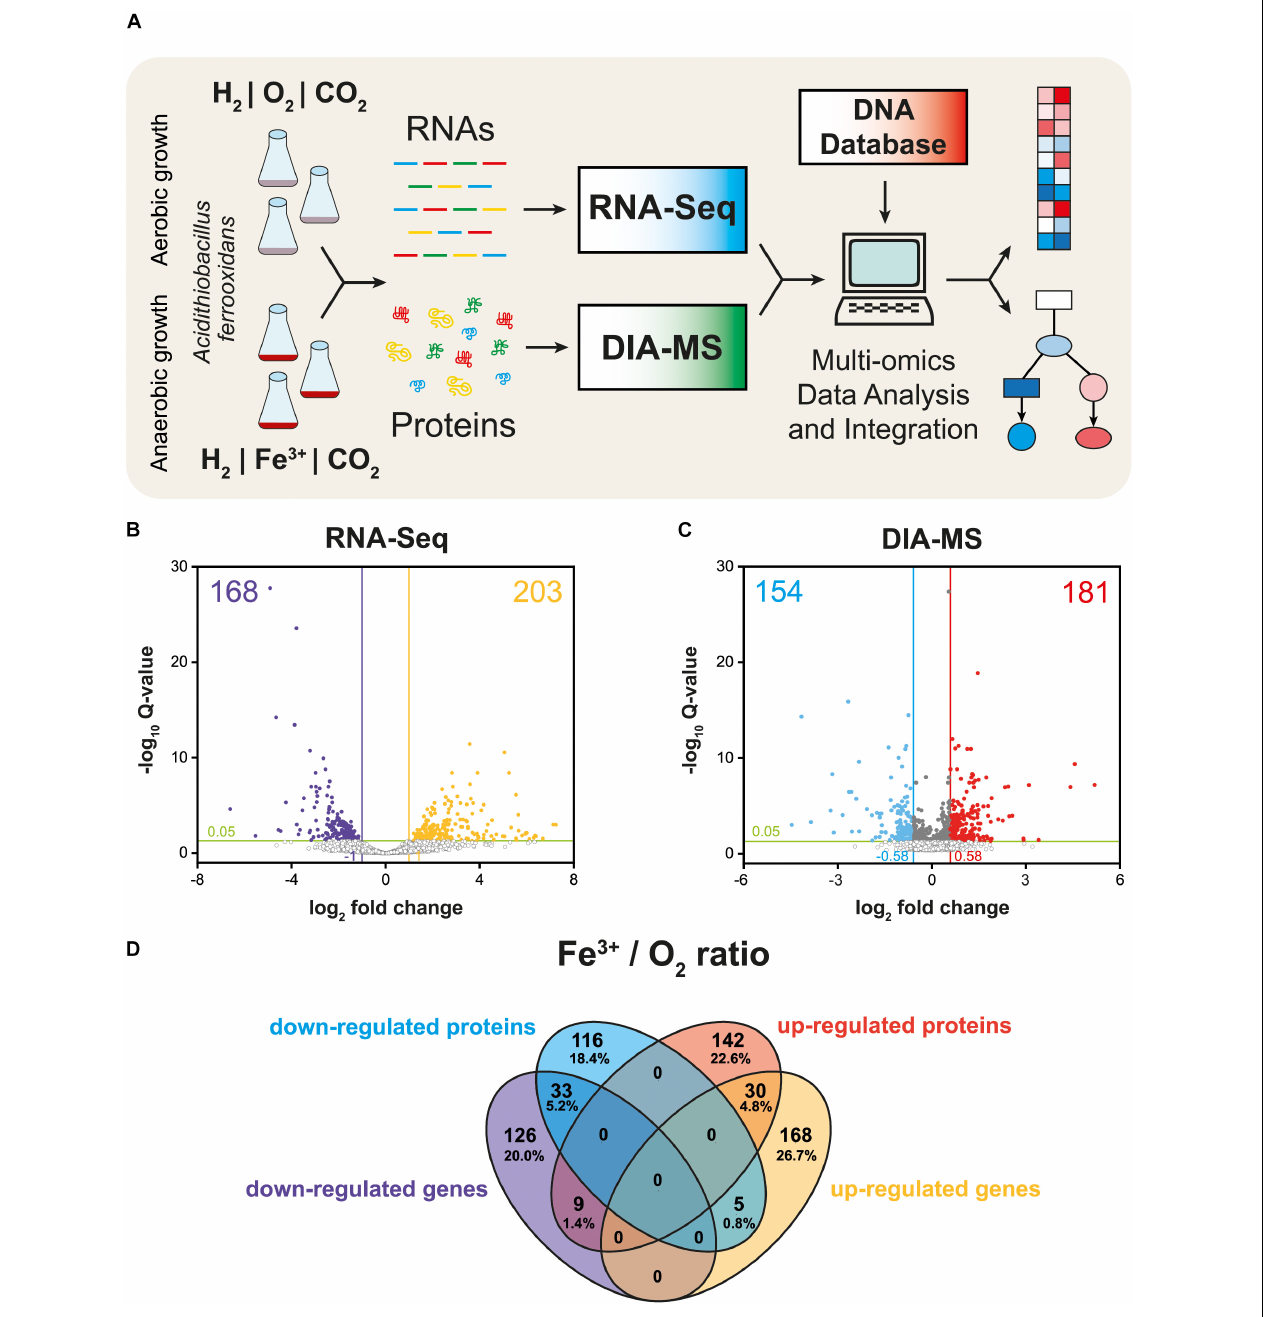
FIGURE 1 | Multi-omics analysis of aerobically and anaerobically grown At. ferrooxidans cells with hydrogen as an electron donor. Experimental design including cultivation, next-generation sequencing, quantitative proteomics, and bioinformatic data analysis (A) . Volcano plot representing all expressed genes (B) . Volcano plot representing all identified proteins (C) . Closed circles indicate gene transcripts and proteins that changed significantly ( q < 0.05); colored circles indicate significant fold change (|log 2 fc| > 1 for gene transcripts, and 0.58 for proteins, respectively). Venn diagram displays significant differentially expressed genes (DEGs) and proteins (DEPs) values ( q < 0.05) with |log 2 fc| > 1 for gene transcripts, and 0.58 for proteins, respectively (D) .